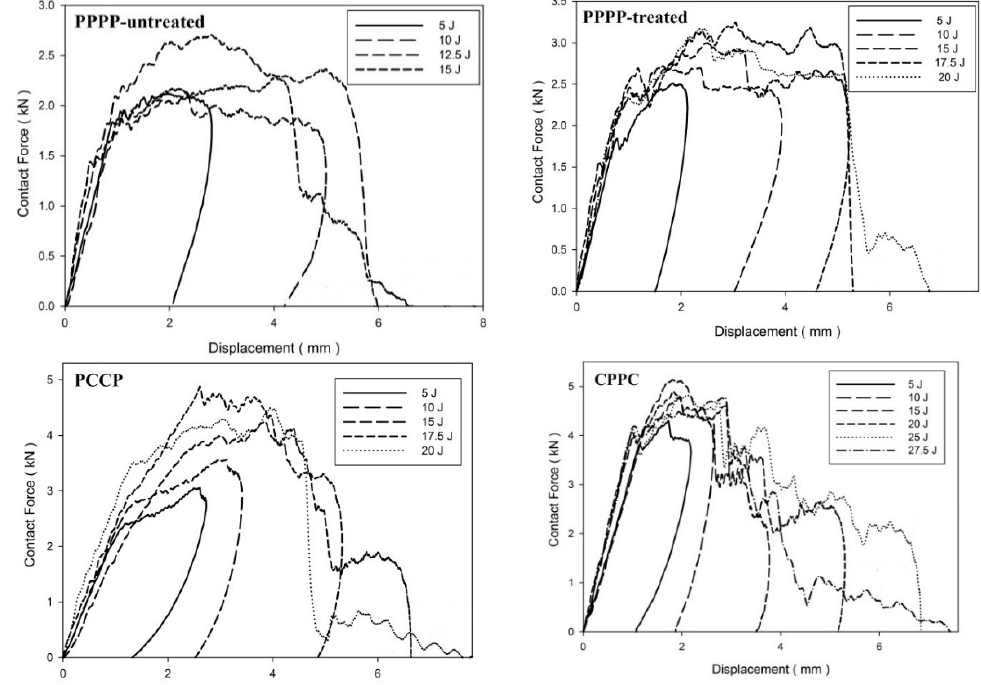
Figure 12. Contact force–displacement of the hybrid laminates at ply orientations of [0°/90° 2 , ±45° 2 ] s .